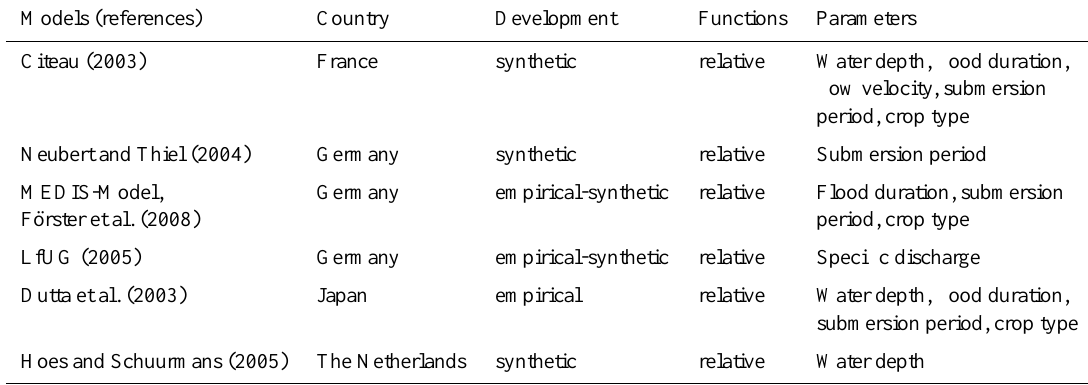
Table 8. Comparison of different damage functions for damage to